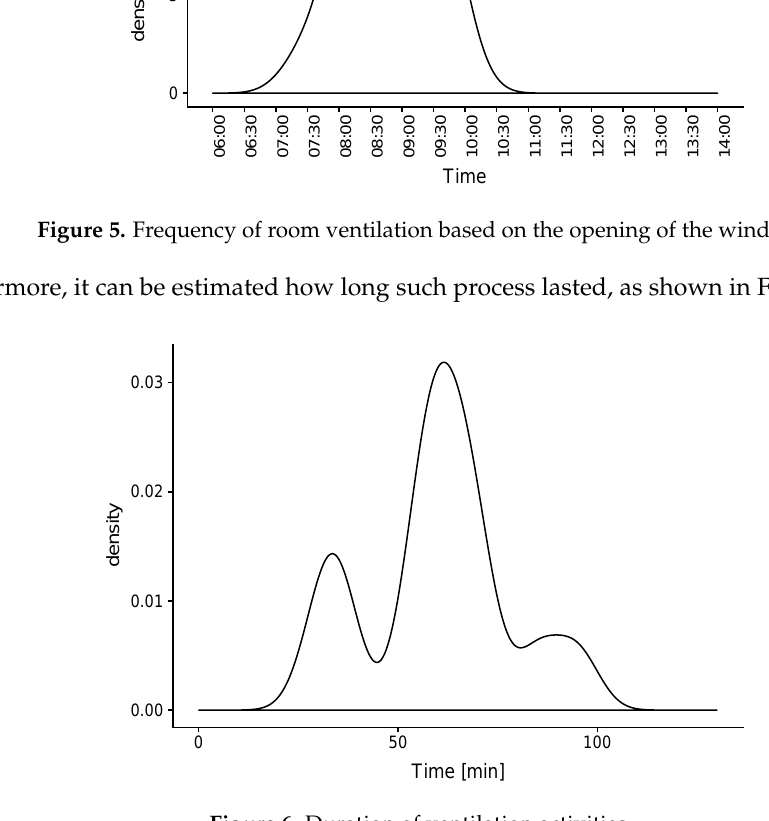
Figure 6. Duration of ventilation